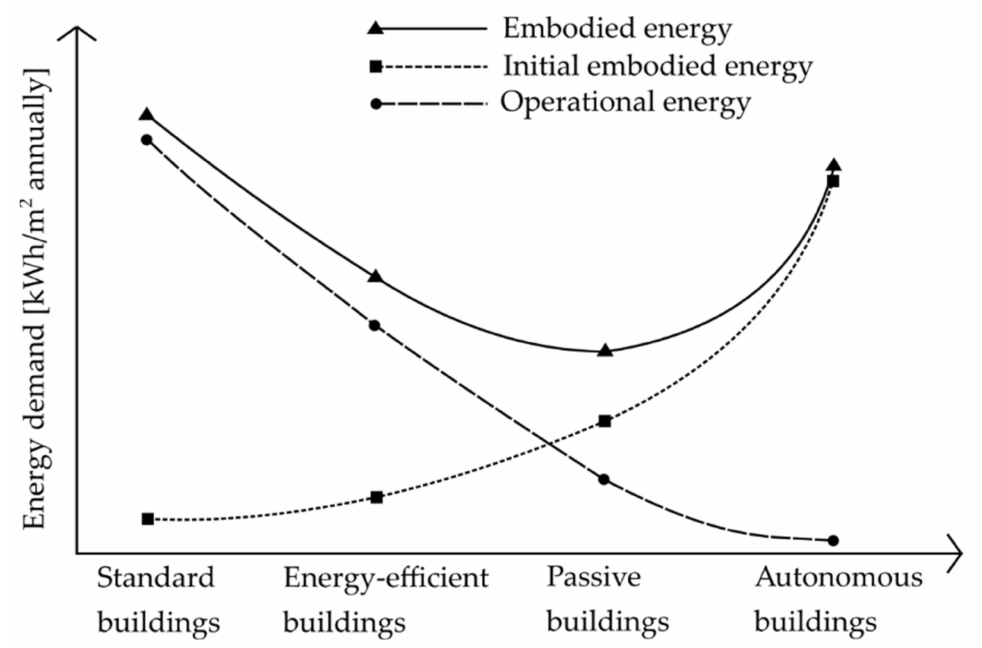
Figure 10. Dependencies between a building’s energy standard and embodied energy and energy consumed during operation. Source: Based on